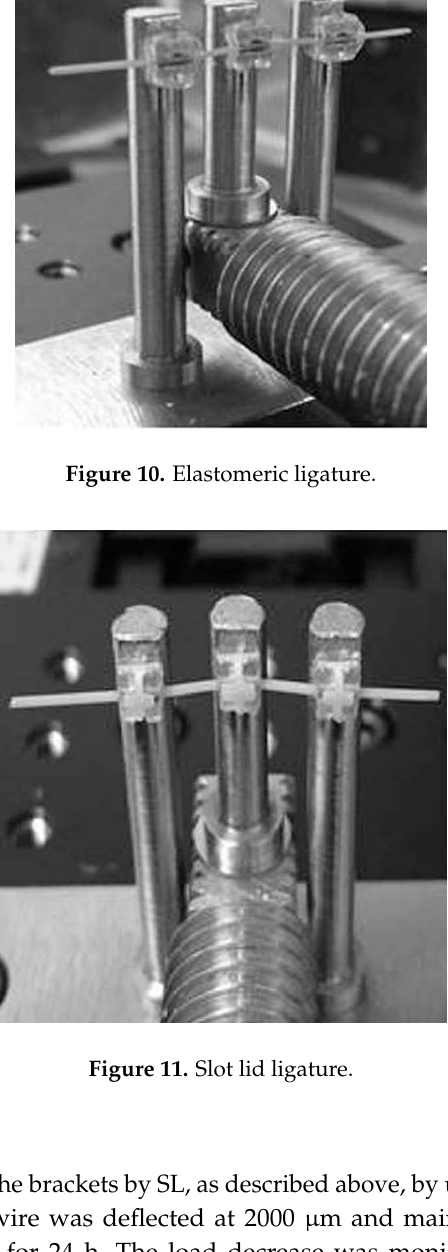
Figure 9. No ligation. A: bracket, B: rod, C: sensor linear gage, D: compression load cell, E: PEEK wire.